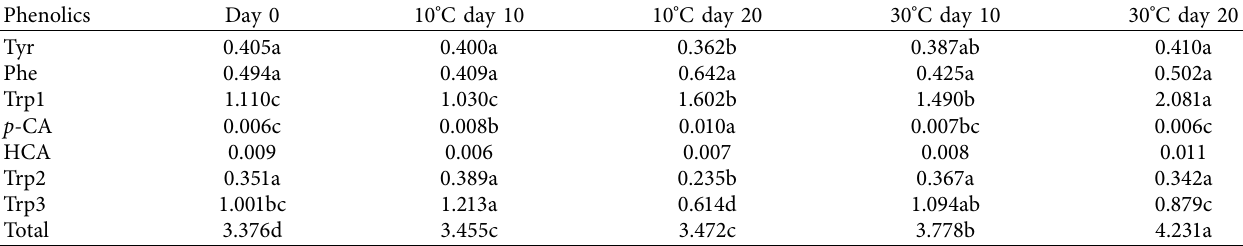
Table 1: Phenolic amino acid concentrations (mg · L − 1 ) in winter melon juices stored under different